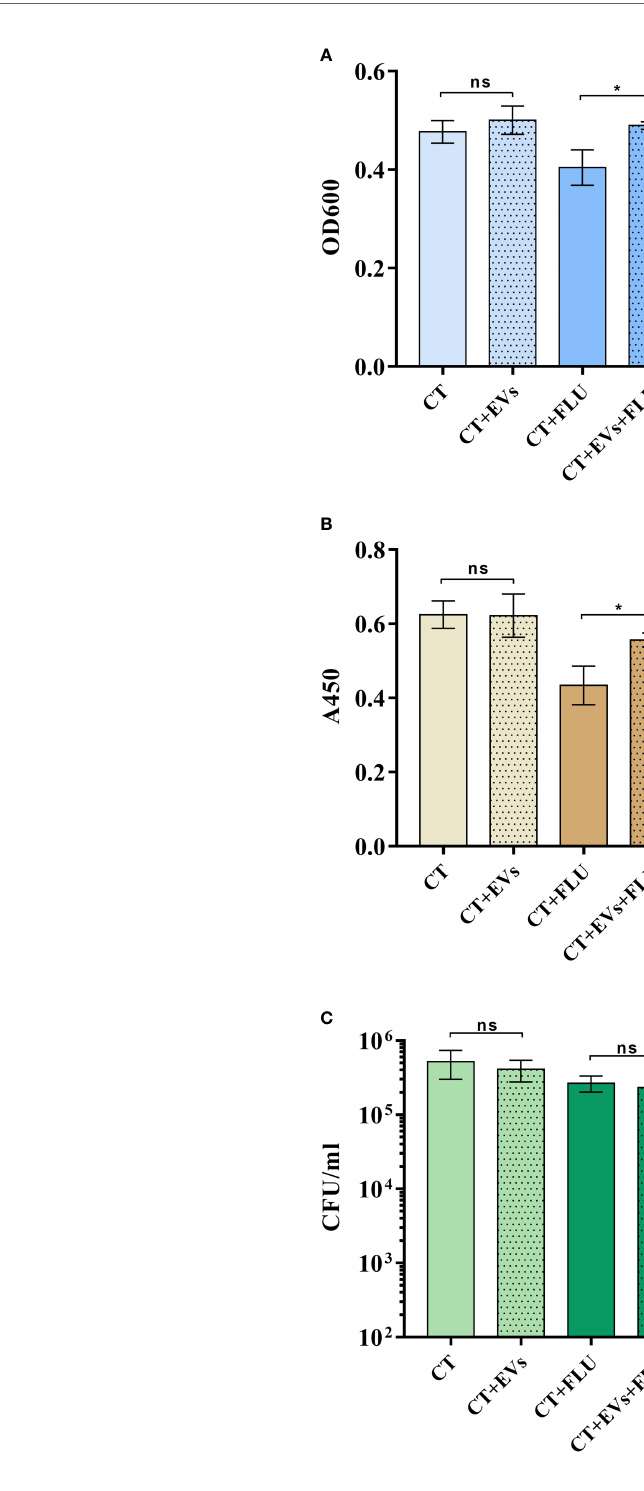
FIGURE 5 | Candida tropicalis bio fi lm formation in the presence of C. tropicalis bio fi lm-derived EVs and the antifungal drugs fl uconazole (FLU) and caspofungin (CASP). The thickness of the bio fi lm was investigated by measuring optical density at 600 nm in the area scan mode (A) , the metabolic activity of cells in the bio fi lm by the XTT test (B) , and the viability of the cell by counting CFUs (C) . A representative result of three independent experiments is presented. To analyze the statistical signi fi cance between samples, an unpaired t -test was performed with GraphPad Prism software version 7.0. The statistical signi fi cance levels were marked with * for p < 0.05 and ns when not signi fi